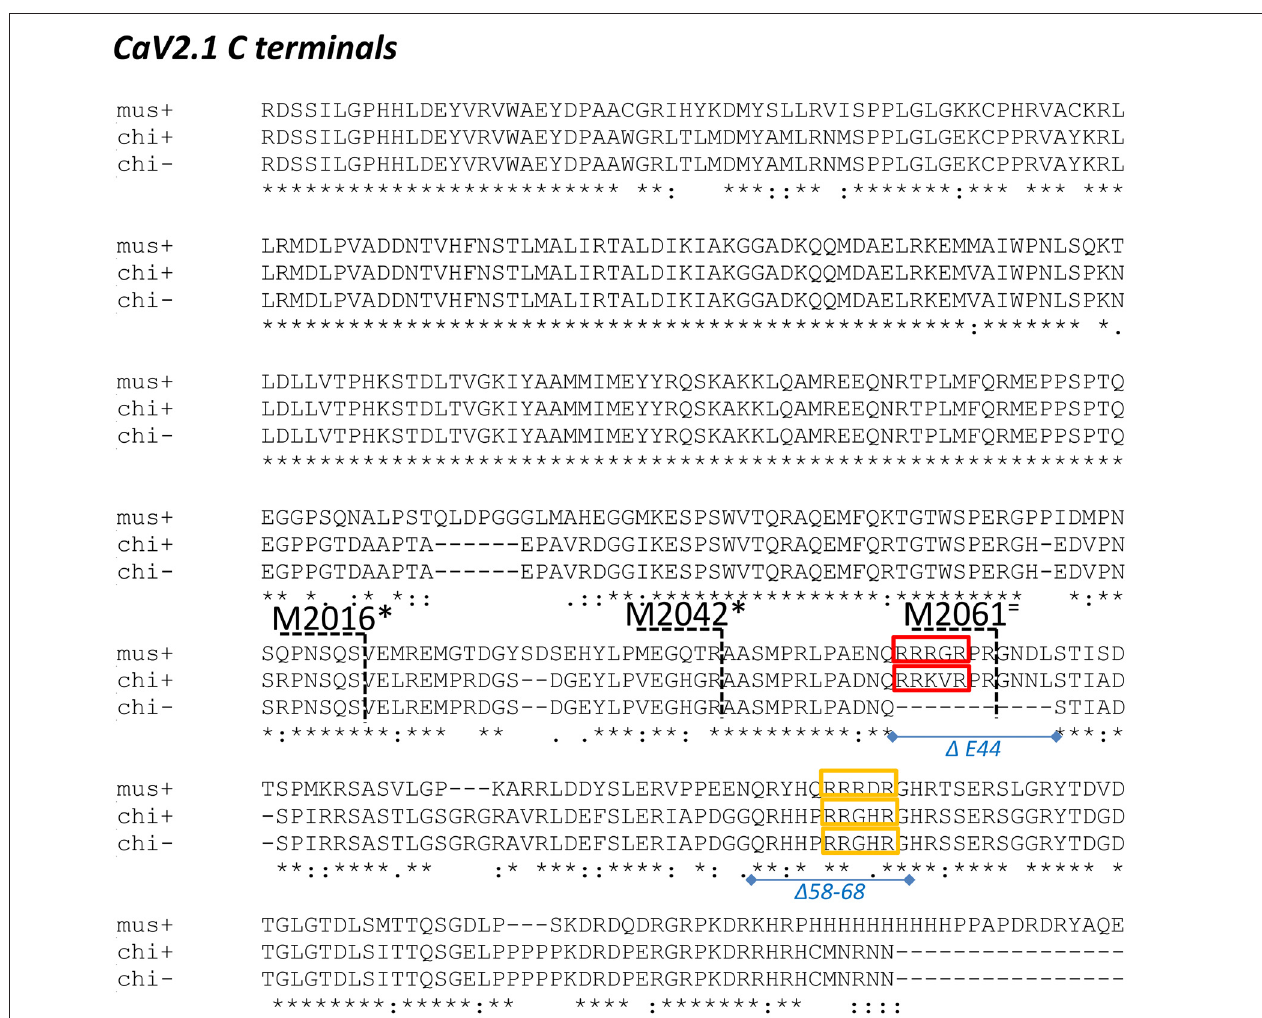
FIGURE 2 | Alignment of chick and mouse CaV2.1 C termini. Chick is shown both with (+) and without (-) the E44 splice insert and the distal third of the mouse C-terminal is not shown. mus: mouse; chi+: full length chicken; chi-: chicken ∆ E44 splice variant. Red and yellow boxes: candidate synaptic vesicle (SV) binding motifs in both species; blue lines and italic text: chick C-terminal deletions; black numbers/dashed lines: mouse C-terminal truncation points as in Lübbert et al. (2017). Truncations that inhibited release are marked with an ∗ and those that did not with an = (see “Discussion”